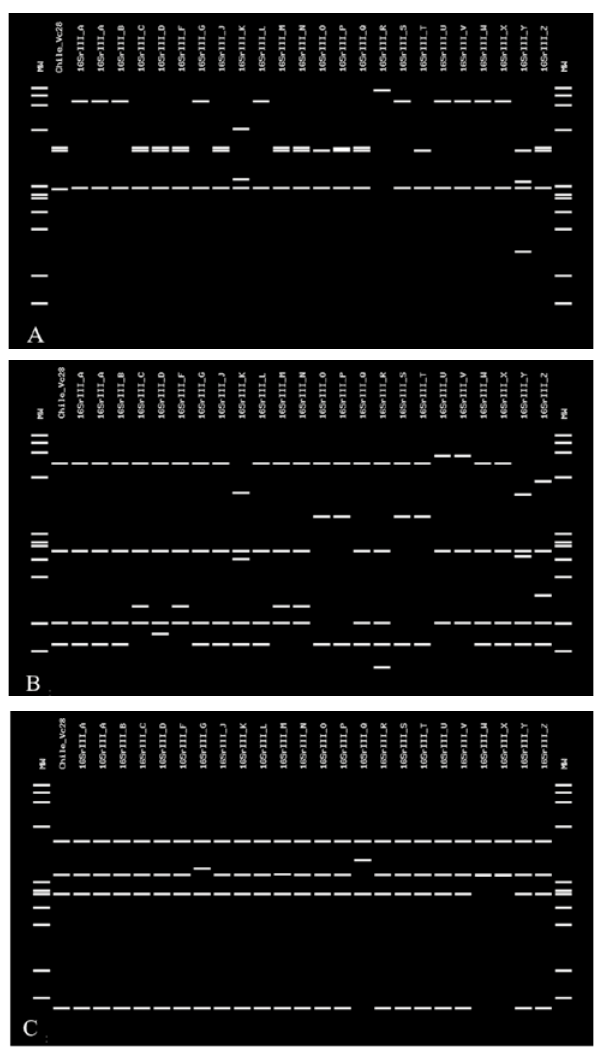
Figure 2. Virtual RFLP patterns obtained from the restriction with Hha I (A); BstU I (B) and Rsa I (C), of a 1,200 bp 16S rRNA gene